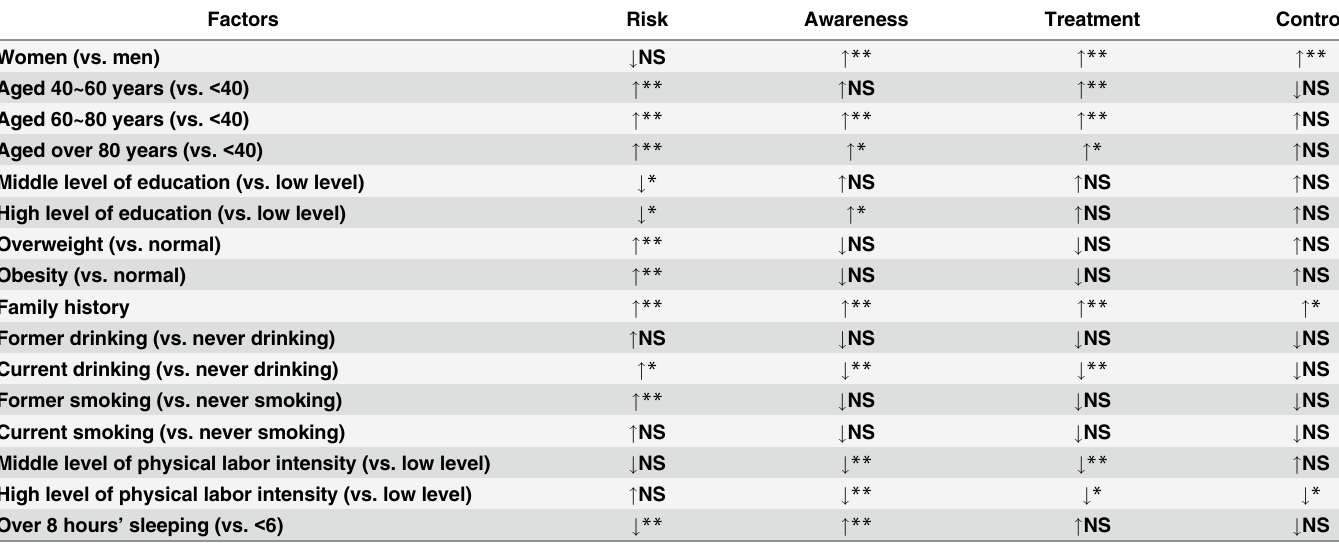
Table 8. Factors related to the risk, awareness, treatment and control of diabetes mellitus. Factors Risk Awareness Treatment